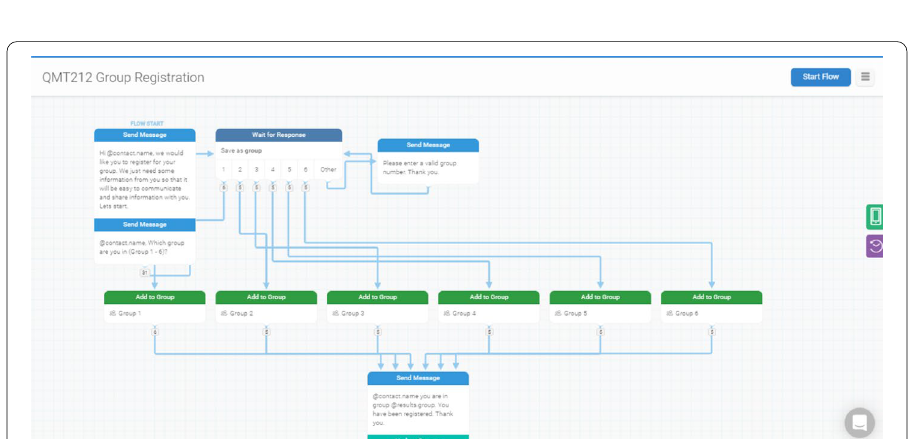
Fig. 2 Textit flow diagram for group registration